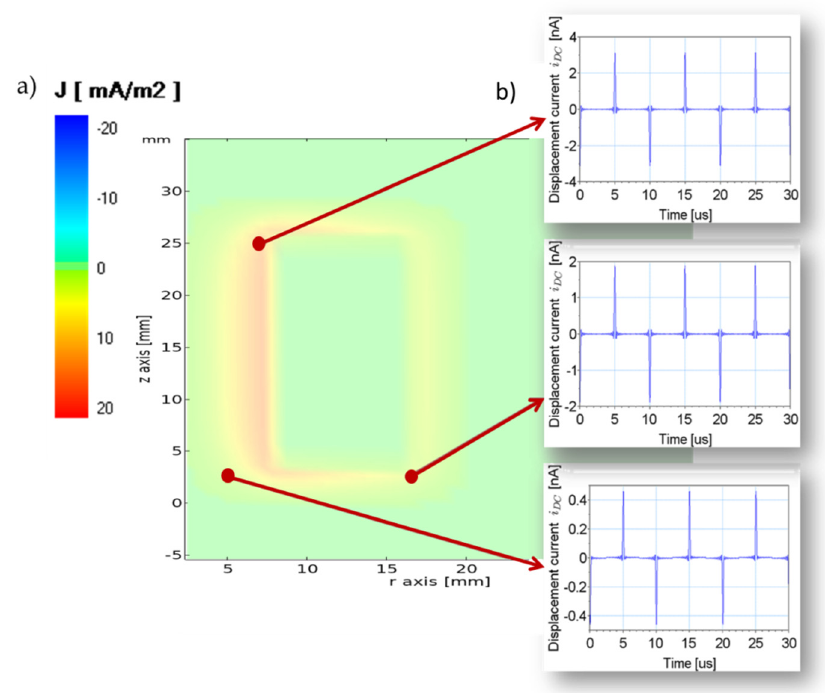
Figure 17. Distribution of the eddy current density in the ferrite core for time t = 9 us ( a ) and the waveforms of the eddy currents for three selected points of ferrite core ( b ) for a frequency of 100 kHz.